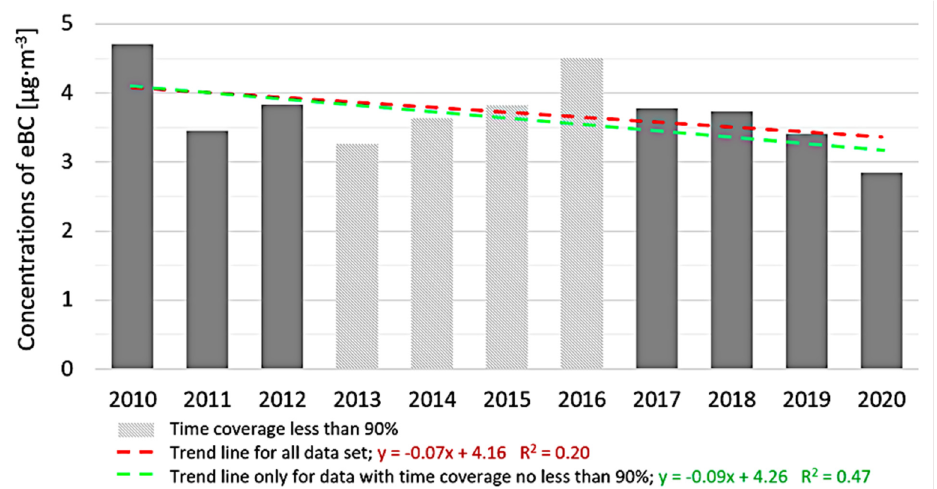
Figure 3. Trend of changes of annual average course of eBC concentrations ( µ g · m − 3 ). (The Kendall robust line-fit method was used for the trend analysis).